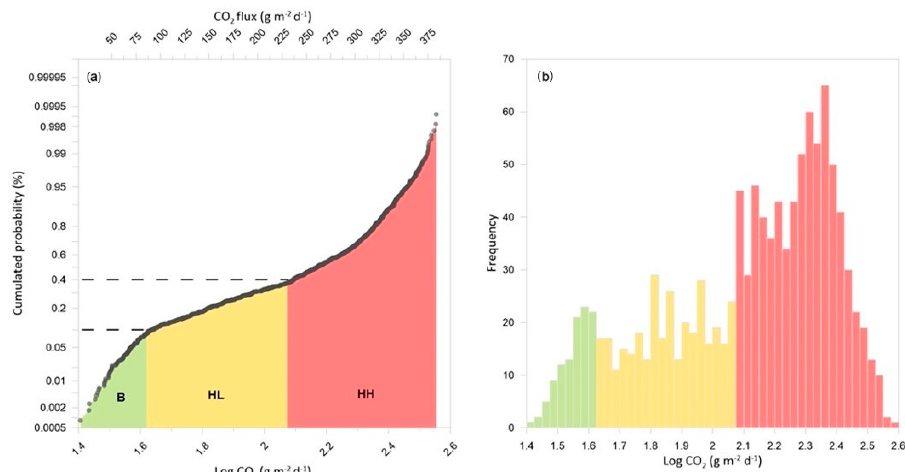
Figure 4. ( a ) Cumulative probability diagram of log CO 2 flux; the data distribution highlights three main degassing families with respectively 10 (B), 30 (HL), and 60% (HH) of cumulated frequency representing respectively the biological soil respiration, hydrothermal low degassing, and hydrothermal high degassing. ( b ) Histogram of log CO 2 flux frequency.